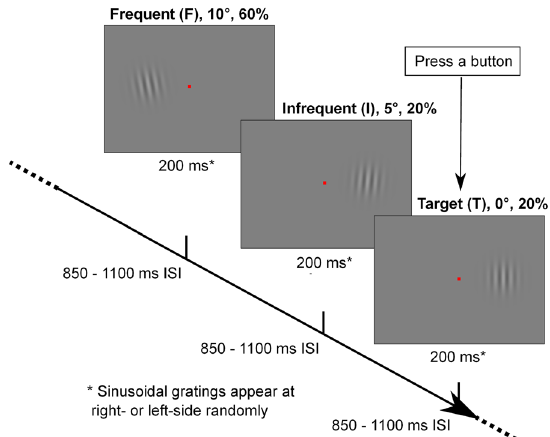
Fig. 2 Representative examples of the sinusoidal grating stimuli and the time sequence of the task. A 10° angular sinusoidal grating was presented as the frequent stimulus (F) at a 60% probability. A 5° angular infrequent (I) stimulus and a 0° angular target (T) stimulus were each presented at 20%